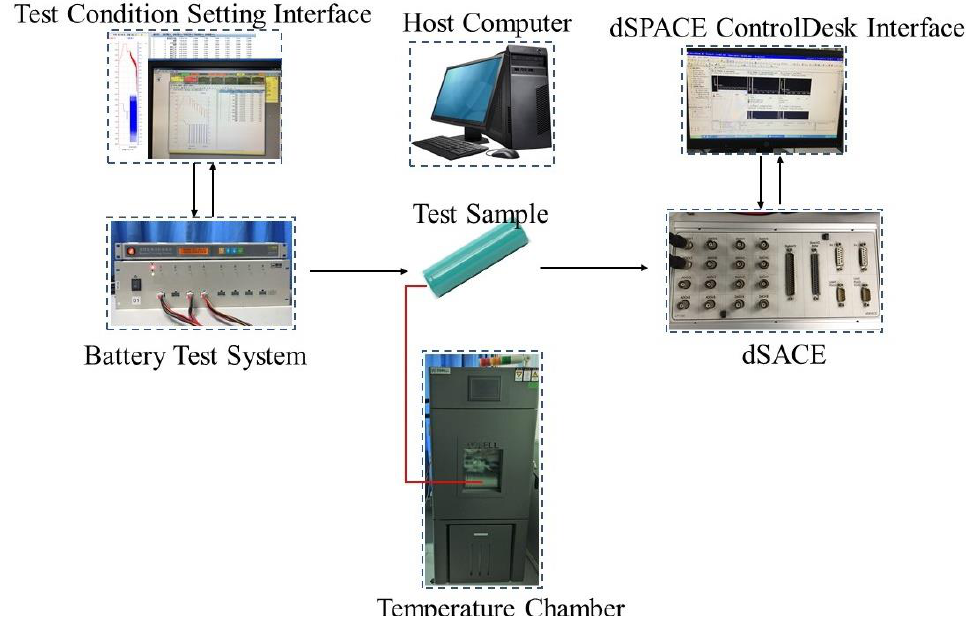
Figure 6. Real-time SoC estimation platform based on dSPACE Rapid Prototyping Systems.